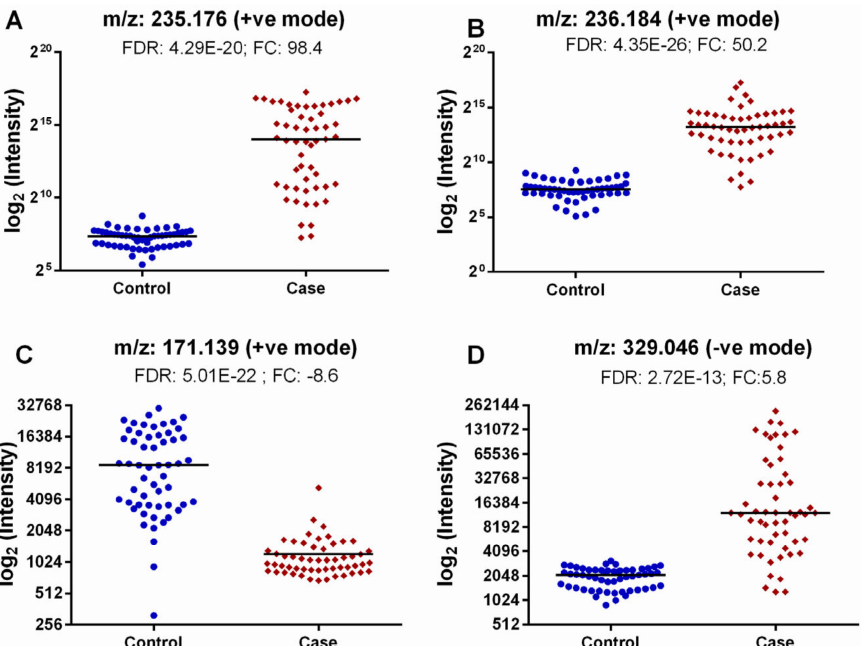
Figure 5. Dot plots of four selected metabolites: L-Arginine (ester), m / z = 235.176 ( A ); N-stearoyl tryp- tophan, m / z = 236.184 ( B ); Caproleic acid, m / z = 171.139 ( C ); 5-[(4-Nitrobenzoyl)amino]-isophthalic acid, m / z = 329.046 ( D